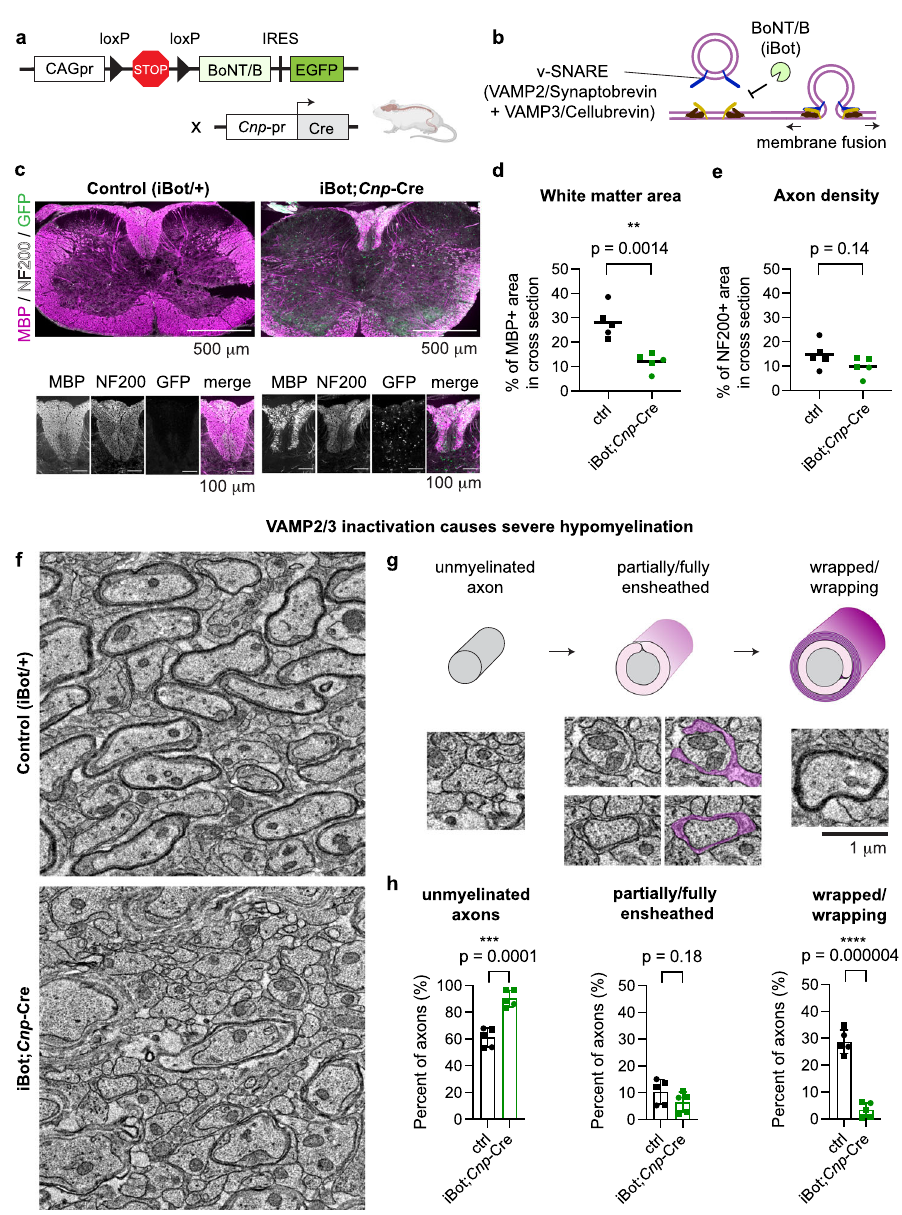
Fig.1|VAMP2/3-mediatedexocytosisisrequiredforCNSmyelination.a Genetic cross for Cre-induced botulinum toxin light chain B (BoNT/B; or “ iBot ” ) under the constitutive CAG promoter (CAGpr) in pre-myelinating oligodendrocytes. Created with BioRender.com. b iBot inactivates v-SNAREs VAMP1 (not depicted), VAMP2, and VAMP3, blocking vesicular fusion to the plasma membrane (exocytosis). c Immunolabeling of P12 spinal cord cross sections from control (iBot/+, left) and iBot; Cnp- Cre (right) mice for MBP (magenta), neuro fi lament heavy chain 200 (NF200, white), and GFP to mark iBot expression (green). Scale bar, 500 μ m. Bot- tom:insets ofdorsalcolumn containing paralleltracts ofaxons. Scale bar, 100 μ m. See Supplementary Fig. 2h for MBP staining of n =5 biologically independent replicates. d Quanti fi cationofwhitematterareade fi nedasthepercentofP12spinal cord cross section area immunolabeled by the myelin marker MBP. Squares and circles denote males and females, respectively. Average±SEM for n =5; control: 28.1±2.97%; iBot; Cnp -Cre: 11.9±1.63%, statistical measurement ( p -value) deter- mined by an unpaired, two-tailed t-test. Source data are provided in the Source Data fi le. e Quanti fi cation of the percent of P12 spinal cord cross section area immunolabeled by the axon marker NF200. Squares and circles denote males and